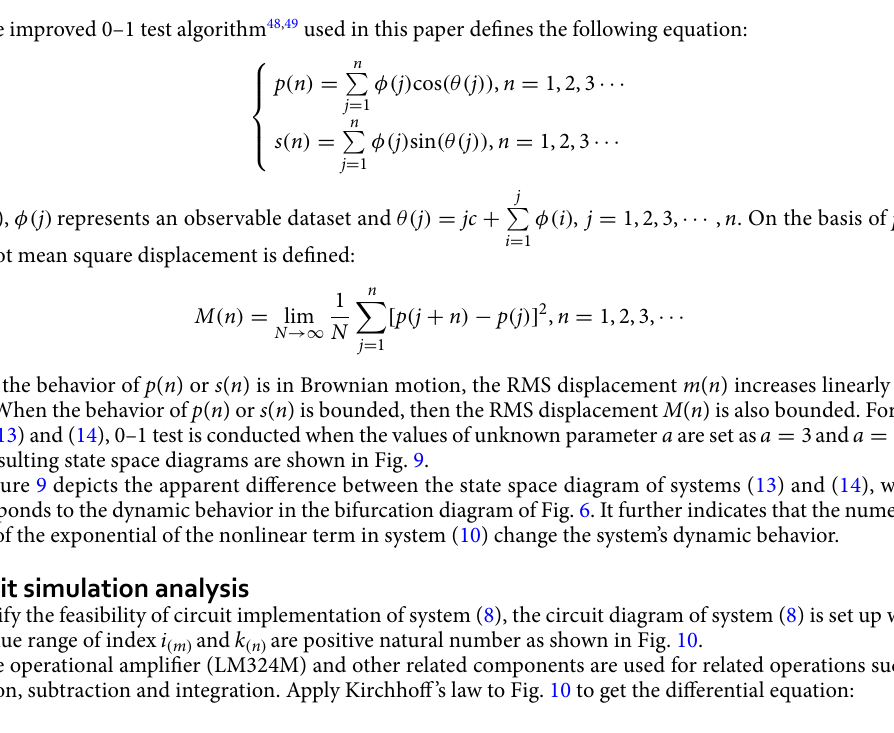
Figure 7. Poincare sections on x 3 poincare section when i ( 3 ) poincare section when i ( 3 )